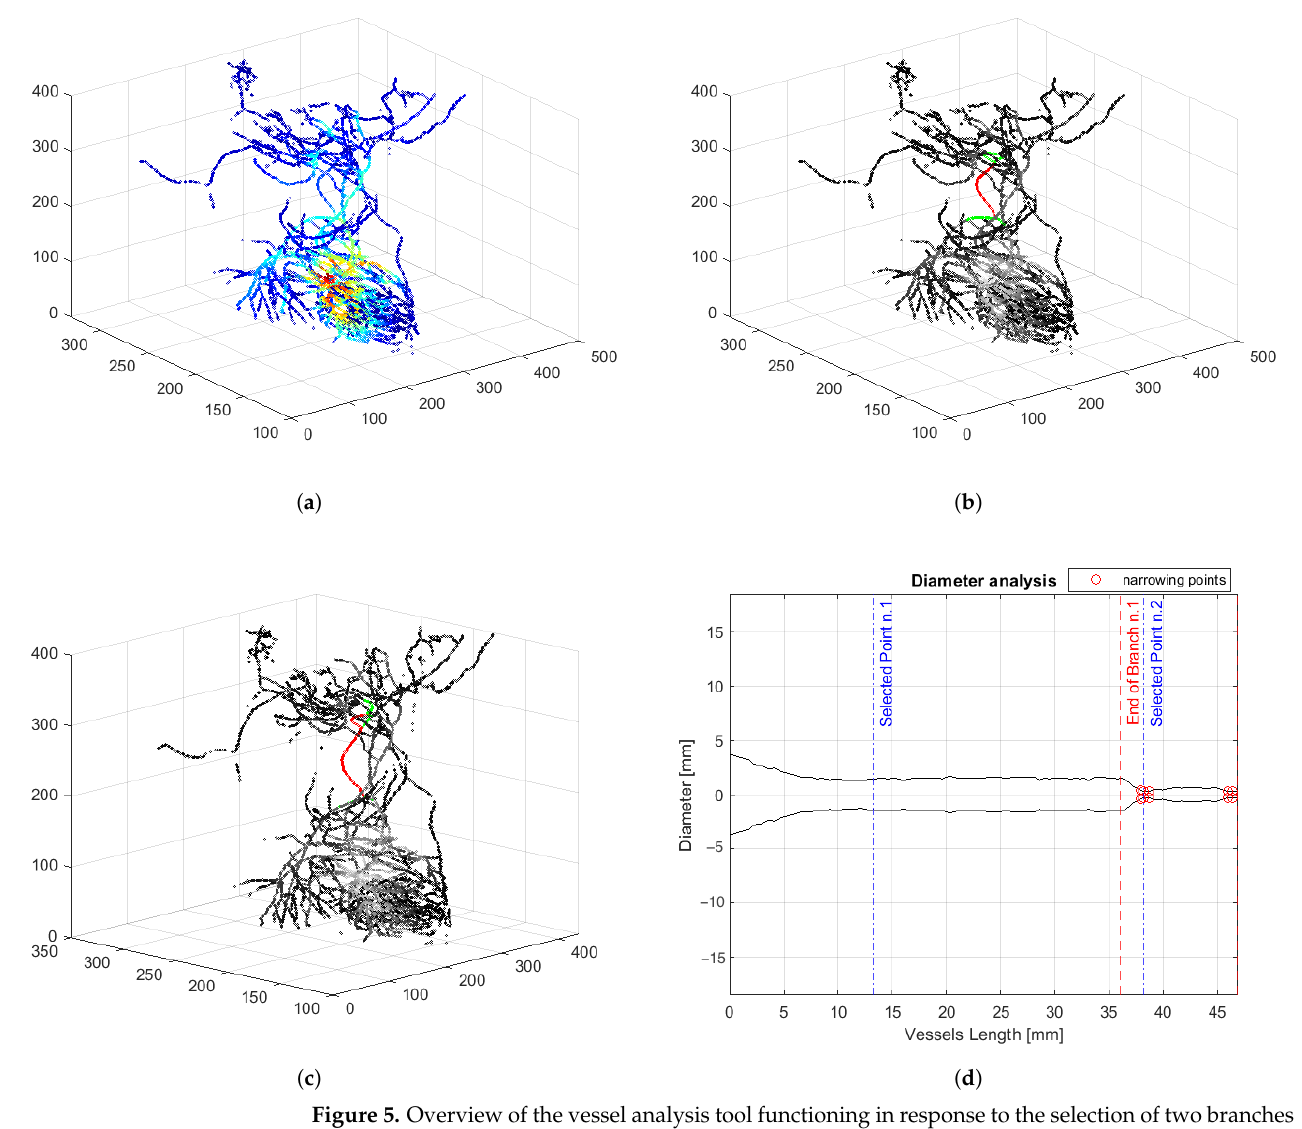
Figure 5. Overview of the vessel analysis tool functioning in response to the selection of two branches on the skeleton. ( a ) Skeleton of the vascular tree. ( b ) After selecting the first branch, the skeleton is shown in gray-scale skeleton, the selected branch is red, and its adjacent segments are green. ( c ) Once the second branch is selected, the GUI shows all selected branches in red and adjacent tracts of the last selected segment in green. ( d ) Linear representation of the